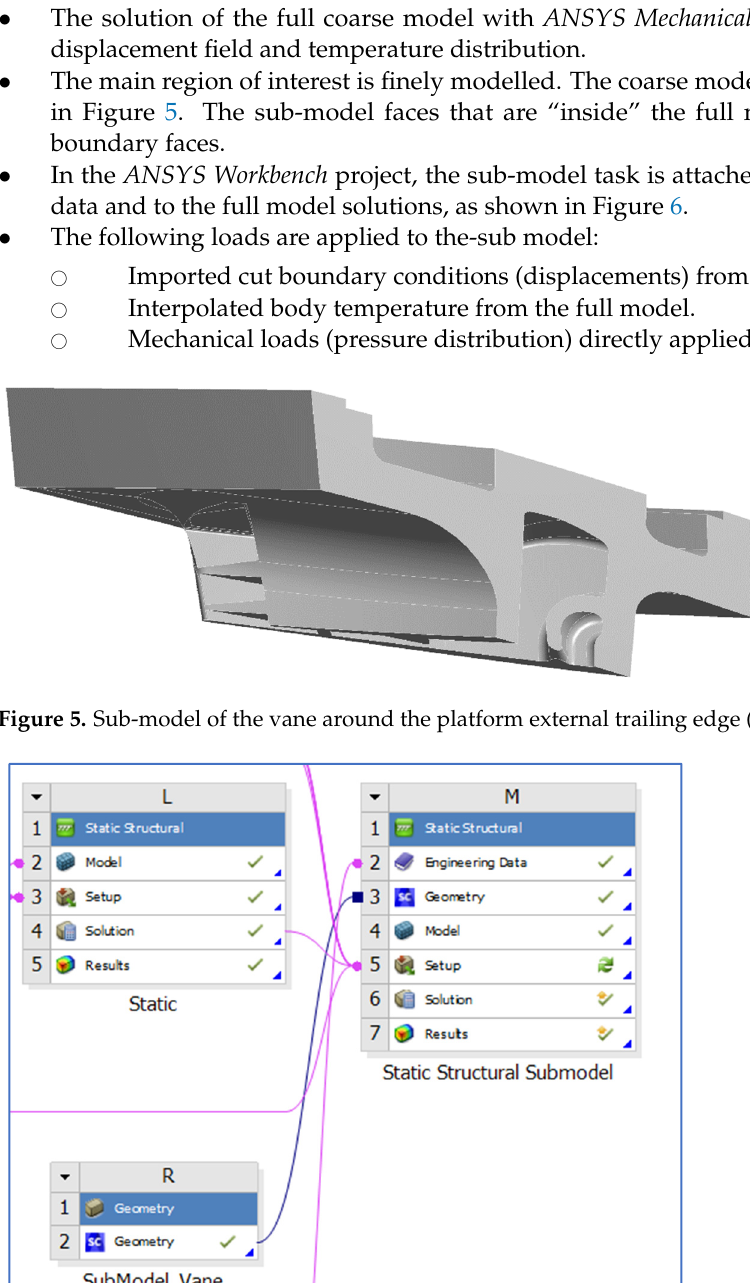
Figure 7. Mesh around the PETE with a sphere of influence of 8 mm radius and 0.5 mm element size. The rest of the sub-model was meshed with quadratic tetrahedron elements , such as the element SOLID187, with dimensions of 1.5 mm. This element is a higher order 3-D, 10- node element with a quadratic displacement behavior, well suited to modelling irregular meshes. The element geometry is illustrated in Figure 8. Figure 9a shows the refined mesh, while Figure 9b details the sphere of influence that give a more refined mesh around the critical location.